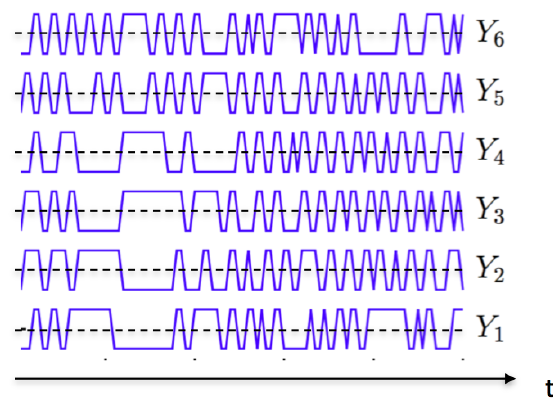
Figure 1: Time diagrams of neurons outputs (case 1)